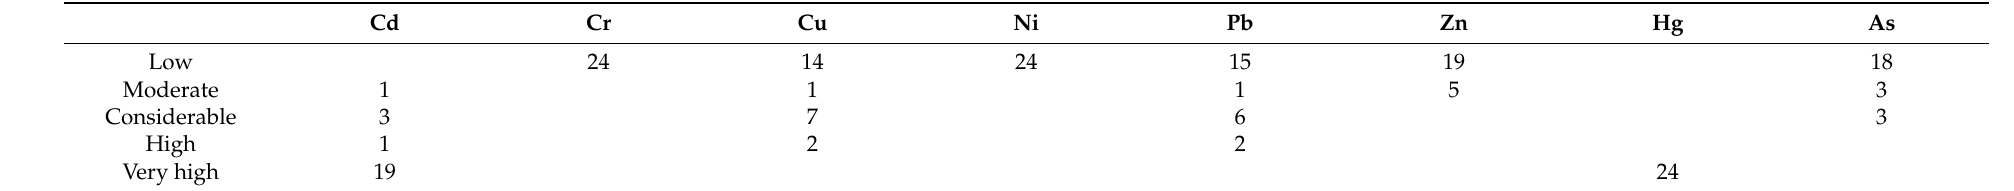
Table 6. The amount of each heavy metal at each ecological